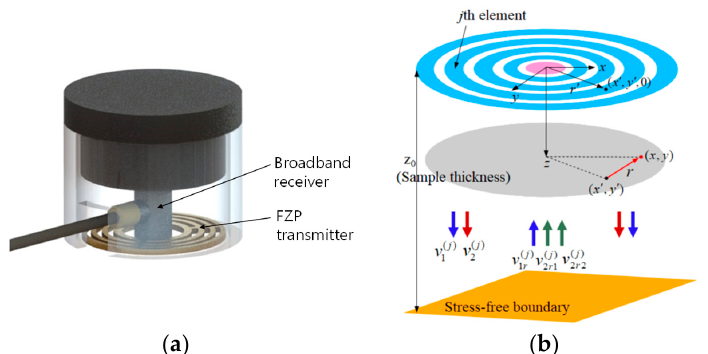
Figure 1. Schematic of a Fresnel zone plate (FZP) sensor and the second harmonic generation (SHG) process in the pulse-echo mode: ( a ) Conceptual design of the FZP sensor and ( b ) radiation from the j th element of a FZP transmitter, reflection from the planar stress-free boundary and reception by a circular receiver placed at the center.